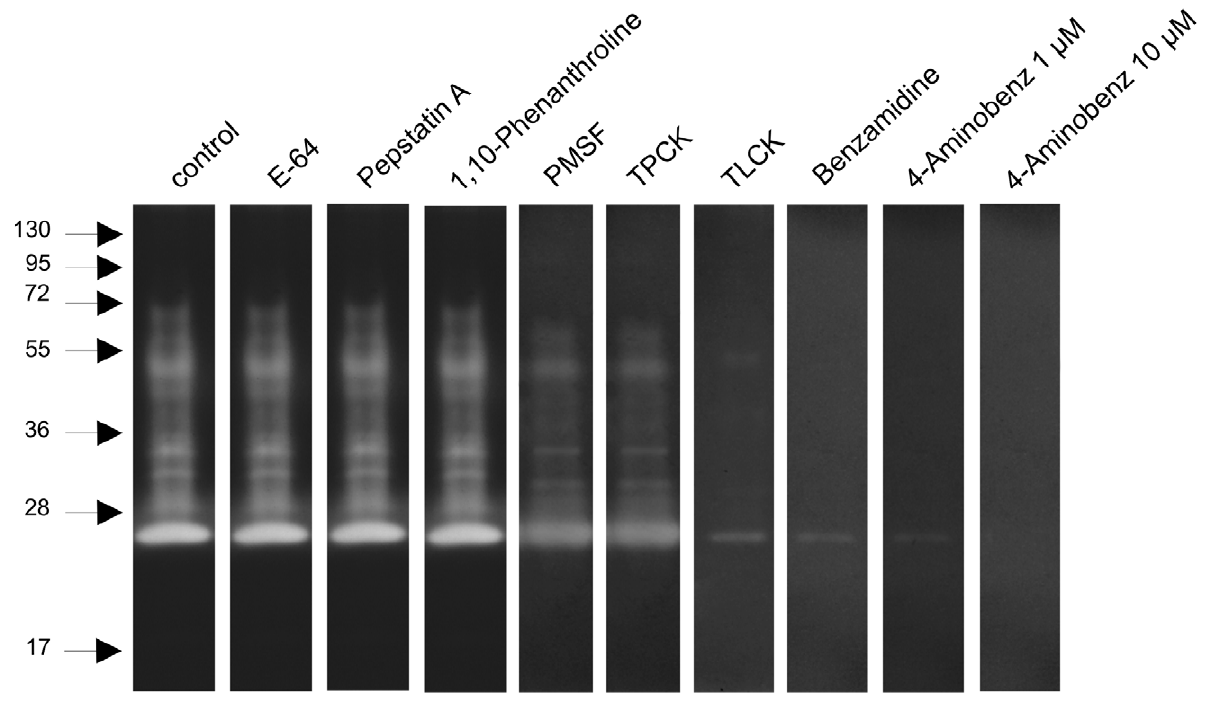
Figure 6. Zymography performed with gelatin co-polymerized gel, incubated at pH 8 with different protease inhibitors, as indicated. Samples corresponding to 1/50 of 1 insect midgut obtained at 12 h ABF were loaded in the gel. Molecular mass standard values (kDa) are indicated by numbers and arrows on the left side of the figure.